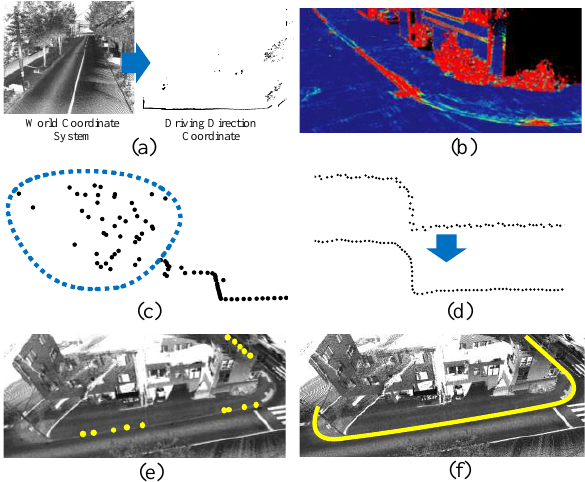
Figure 1. The outline of proposed method. (a) Projection to the driving direction. (b) Calculation of bend angle. (c) Removal of irregular points. (d) Smoothing of scanline. (e) Extraction of seed points of road edges. (f) Extraction of road edges.